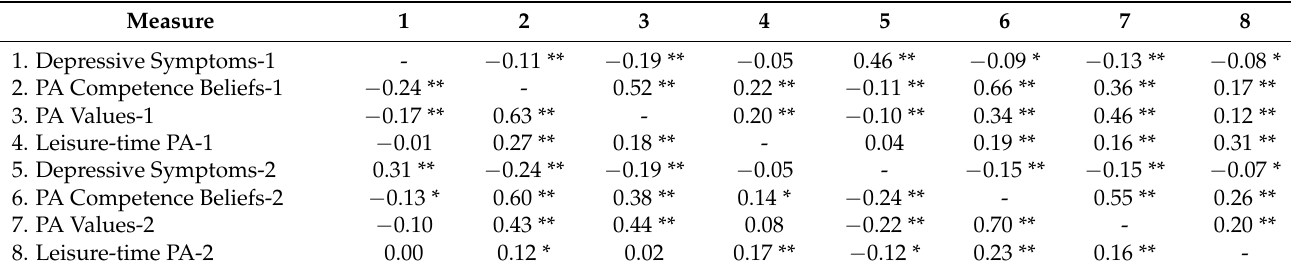
Table 3. Correlations among study variables across Time 1 and Time 2 stratified by sex.